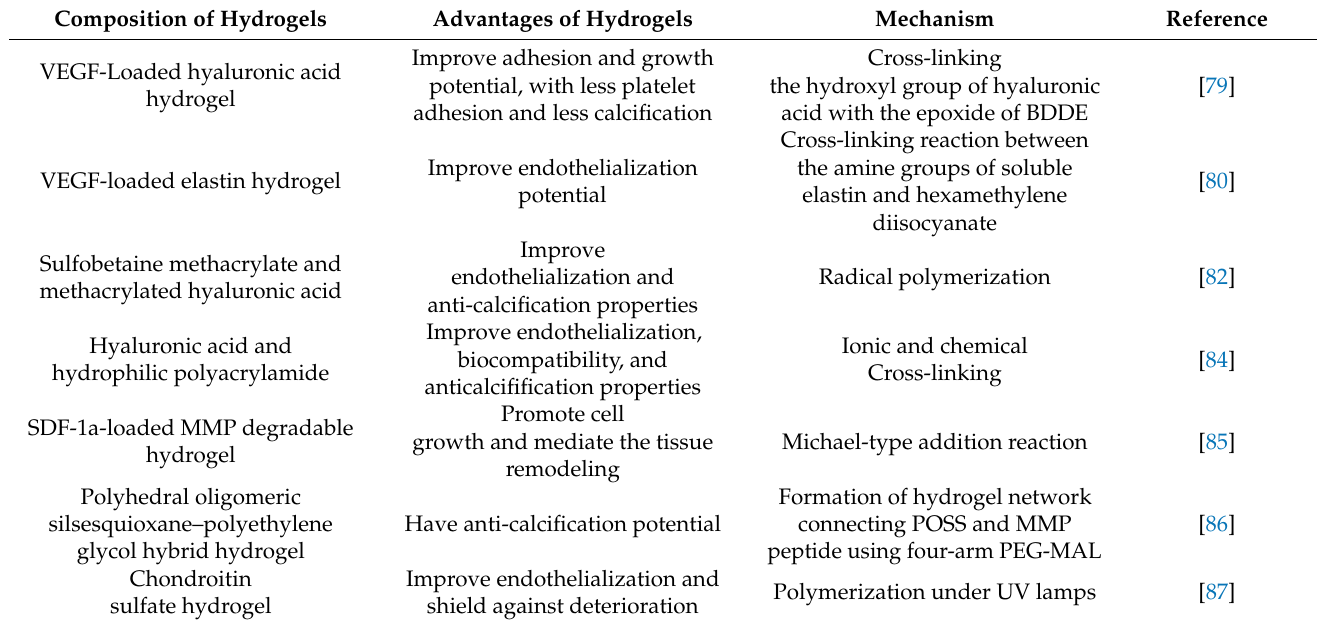
Table 2. Application of hydrogels in the study of tissue-engineered heart